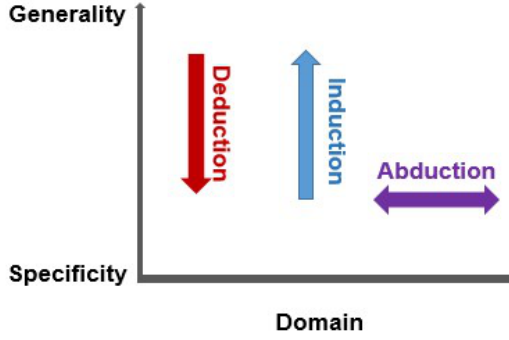
Figure 1. Generality versus Specificity for Deduction, Induction and Abduction.